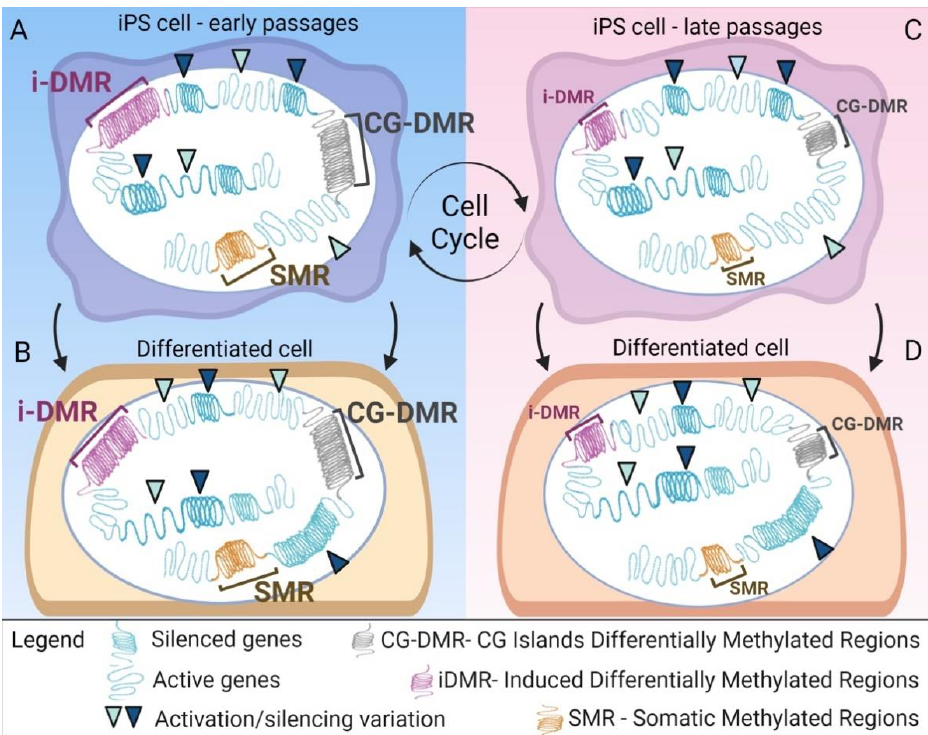
Figure 3. Old and new epigenetic memory in iPSCs. The figure summarizes how the modifications introduced by the reprogramming process fail to fully modify the epigenetic landscape of the original donor cell. Alongside the activation of genes that confer pluripotency characteristics, there are still states of activation, silencing, and methylation characteristic of the donor cell. ( A ) The persistence of methylated regions of the donor somatic cell, SMR (in brown), is found, in addition to the gene activation changes in the genes also related to pluripotency, cell cycling, cellular metabolism, differentiation, and tissue specificity, outlined by arrow points. Furthermore, at the end of the reprogramming process, there are also new aberrant methylation regions, induced (i)DMR (in violet), and methylations particularly concentrated in the CG islands—CG-DMR (in gray). ( B ) These new epigenetic arrangements remain even after the differentiation of the iPSCs into a new cell type. ( C ) With the expansion of iPSCs, there is a decrease in these differently methylated regions, which becomes clear at high passages. ( D ) This variation in the epigenetic landscape is also found in the differentiated